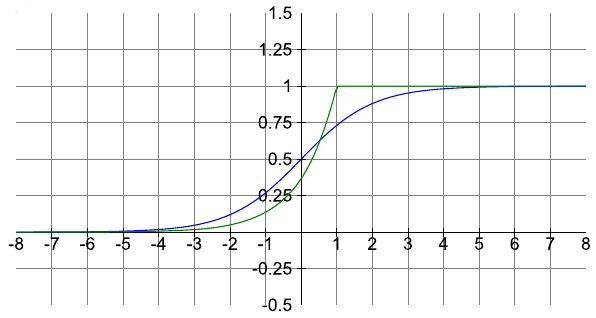
Fig. 2 Plots of two functions on the same coordinate when δ = 0